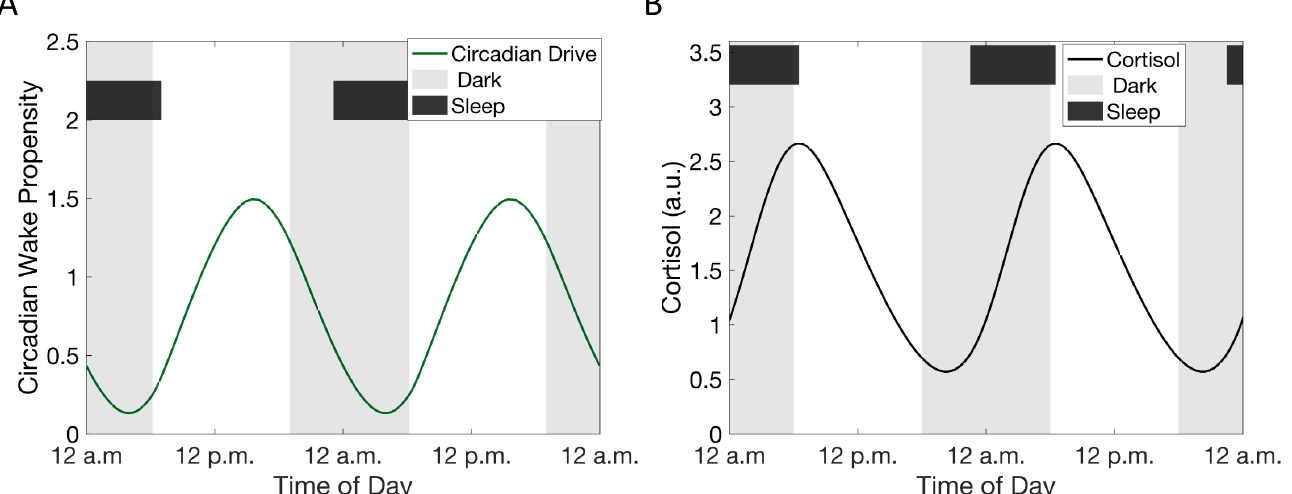
Figure 3. ( A ) The circadian drive (green) of the physiological sleep-wake model that regulates the homeostatic drive and the secretion of CRH in a time-of-day dependent manner. ( B ) The cortisol circadian rhythm (black) given the shown sleep (black shaded bars at top of panels) and light-dark (white and grey shaded regions, respectively) schedules.